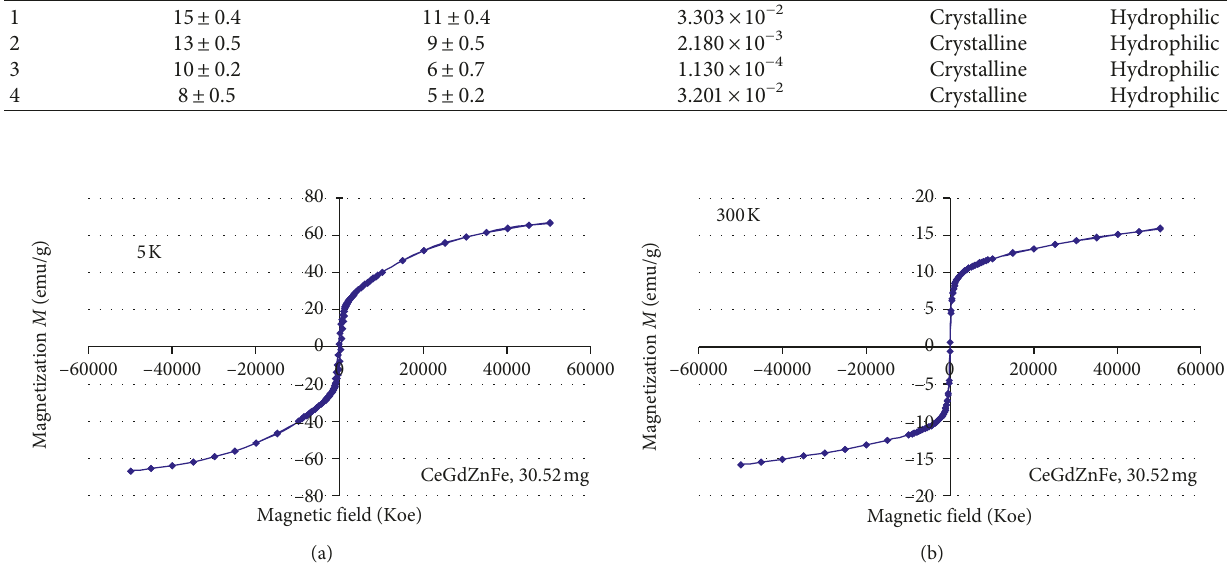
Figure 4: CeGdZn-ferrite nanoparticles magnetization curve taken by SQUID at 5K (a) and at 300 K (b).